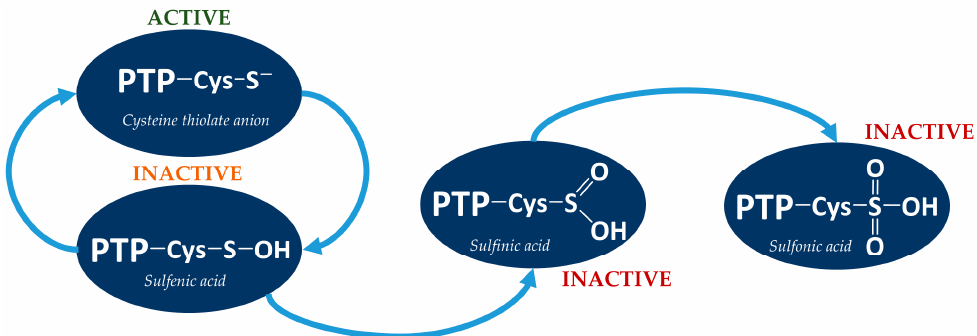
Figure 2. Inactivation of tyrosine phosphatase by oxidation of the catalytic cysteine residue to sufenic, sulfinic or sulfonic acid. sulfinic or sulfonic